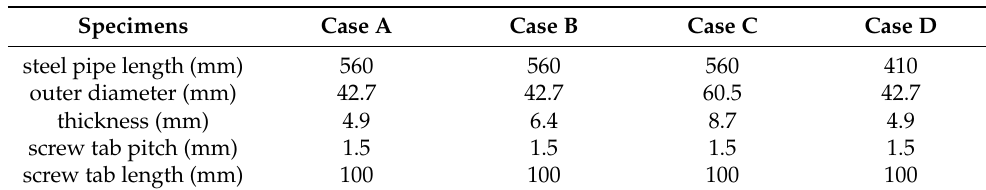
Table 5. Parameters of the round mold specimen.